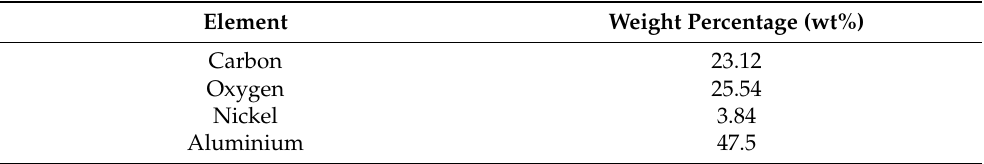
Table 1. Weight percentages of carbon, oxygen, nickel and aluminium of CNTs/alumina hybrid synthesis using the CVD